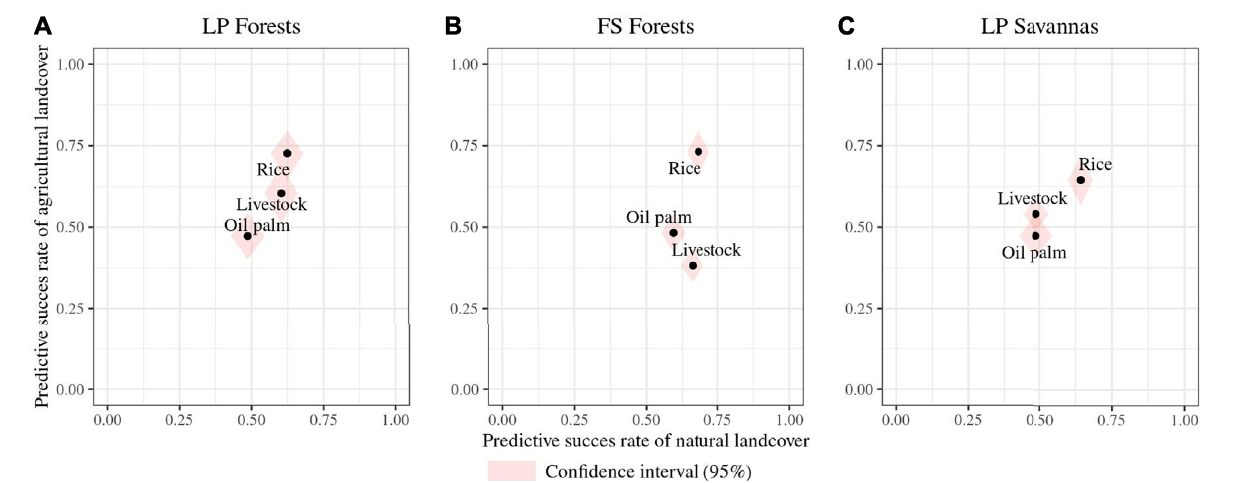
FIGURE 4 | Predictive success rates of the classi fi cation of RF models for changes in species occurrence probabilities (according to traits) in land-use change scenarios. The x -axis represents predictive success to classify species in natural covers, and y -axis represents predictive success to classify species in agricultural covers. The points represent the predictive success of each scenario in which high predictive rates mean a high probability of the change of species occurrence probabilities as a response to land-use changes. (A) . Land-use change scenarios from forests to agricultural covers in the Llanos piedmont (LP) landscape; (B) . land-use change scenarios from forests to agricultural covers in the fl ooded savanna (FS) landscape; (C) . land-use change scenarios from natural savannas to agricultural covers in the FS